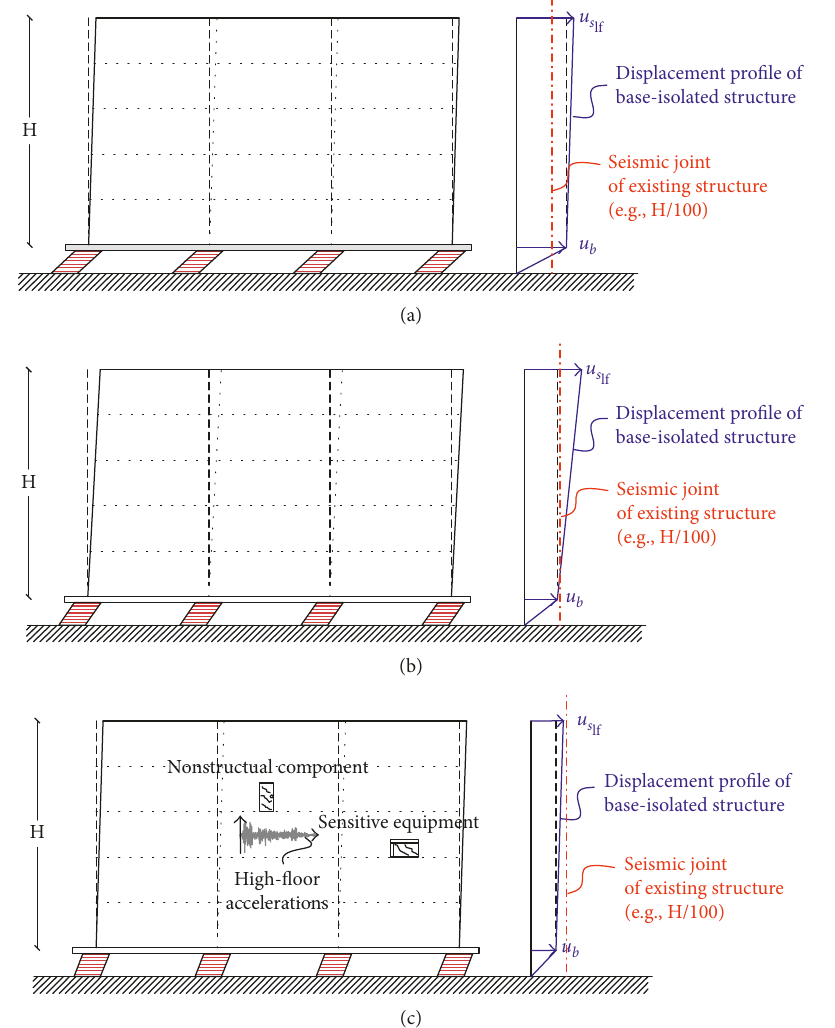
Figure 4: Schematic representation of the displacement demand in base-isolated structures: (a) conventional BIS with medium damping; (b) low-period BIS with medium damping; (c) high-damping